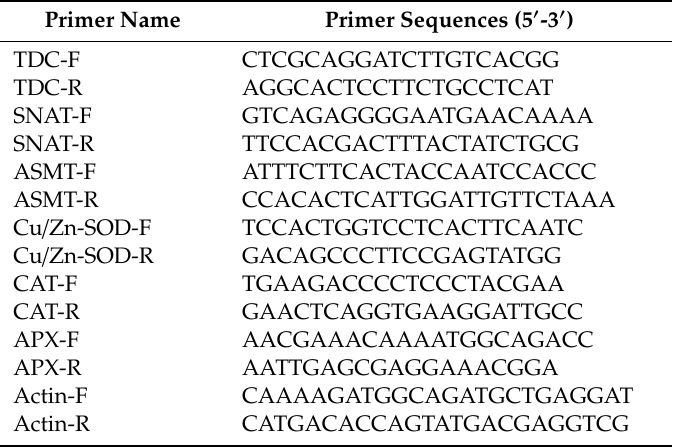
Table 1. Primers list used in